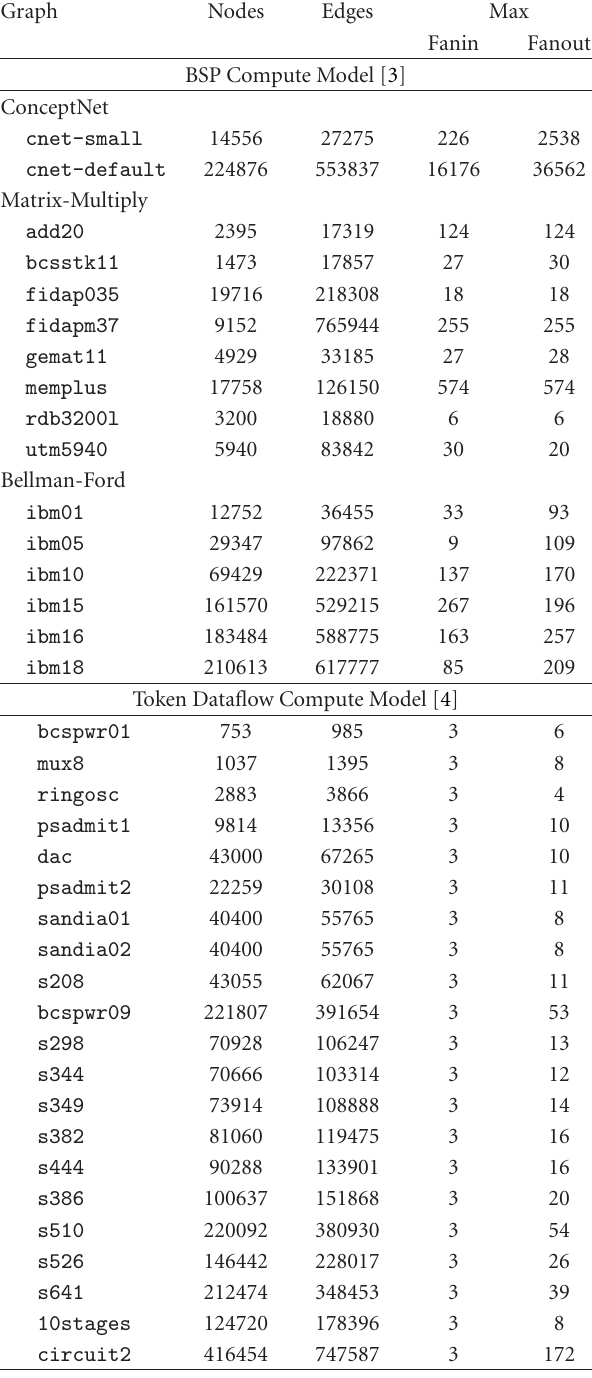
Table 1: Application graphs.